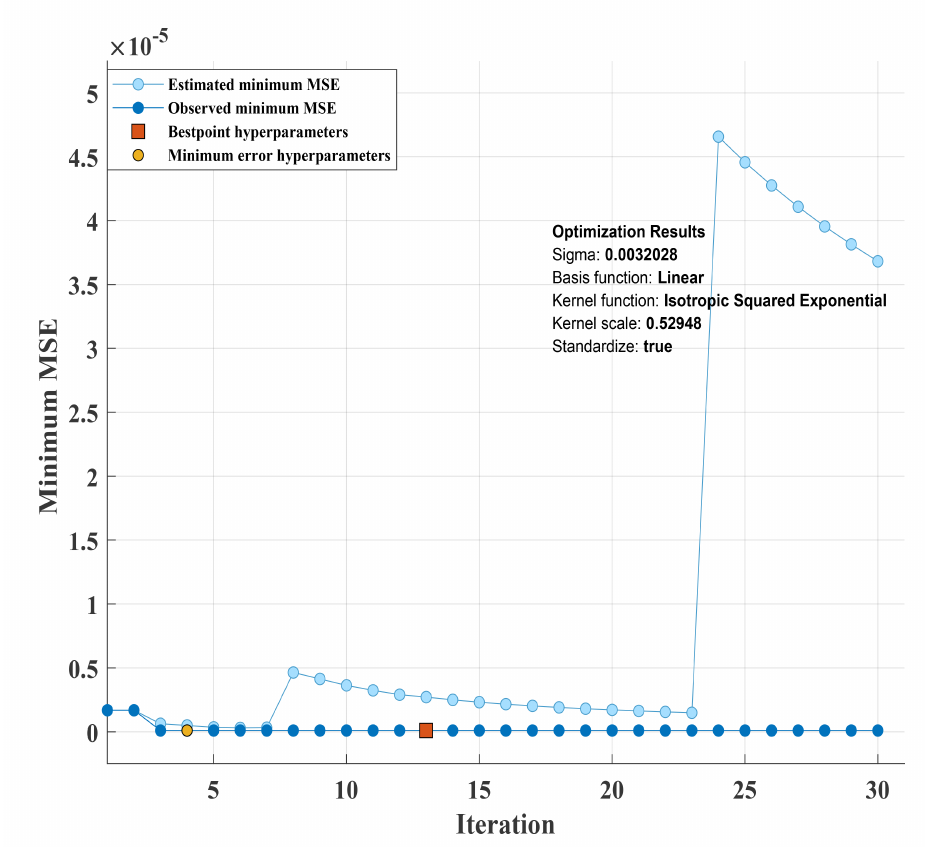
Figure 4. Optimization of the GPR model with maximum and minimum mean square error with different